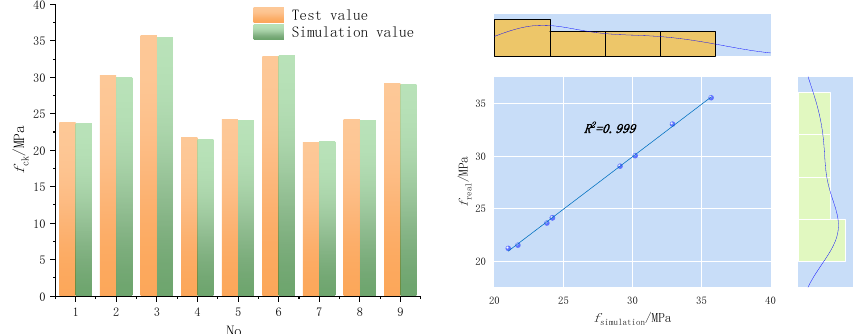
Figure 4. Comparison of test and simulation values.